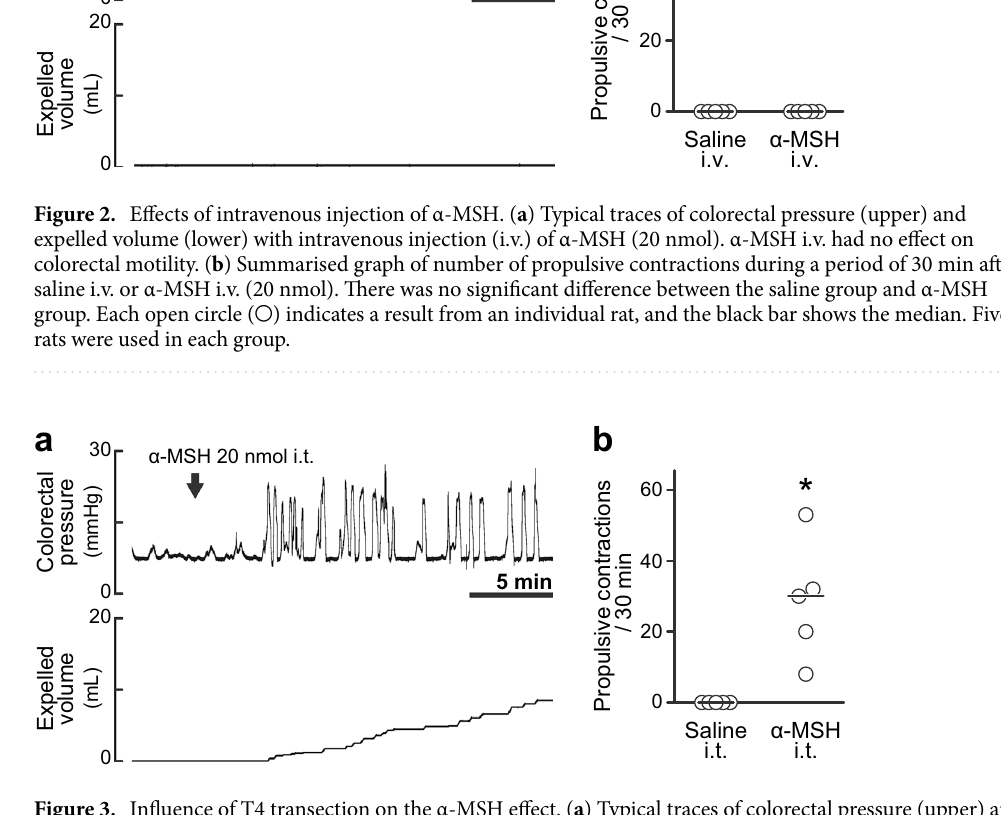
Figure 3. Influence of T4 transection on the α-MSH effect. ( a ) Typical traces of colorectal pressure (upper) and expelled volume (lower) with α-MSH (20 nmol, i.t.) in a rat in which the thoracic spinal cord was transected at the T4 level. α-MSH i.t. caused propulsive contractions. ( b ) Summarised graph of number of propulsive contractions during a period of 30 min after saline i.t. or α-MSH i.t. (20 nmol) in spinalised rats. α-MSH (20 nmol, i.t.) significantly increased the number of propulsive contractions in spinalised rats compared to that in the saline group. Each open circle ( ○ ) indicates a result from an individual rat, and the black bar shows the median. *Denotes a significant difference from the saline group ( P < 0.05). Five rats were used in each